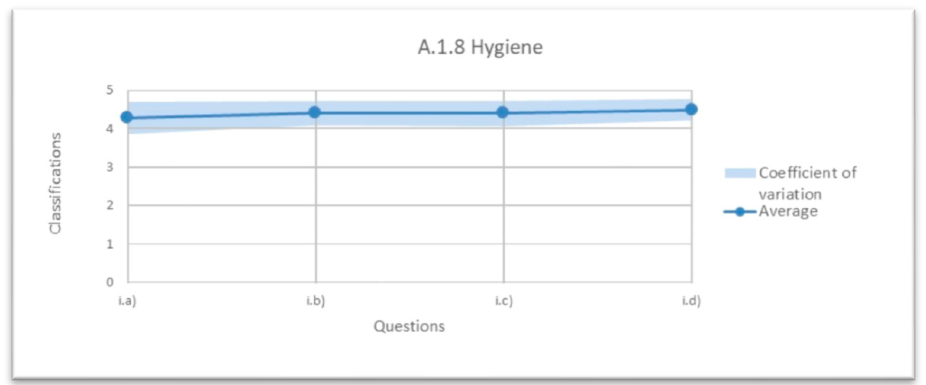
Figure 8. Average ratings of hygiene.